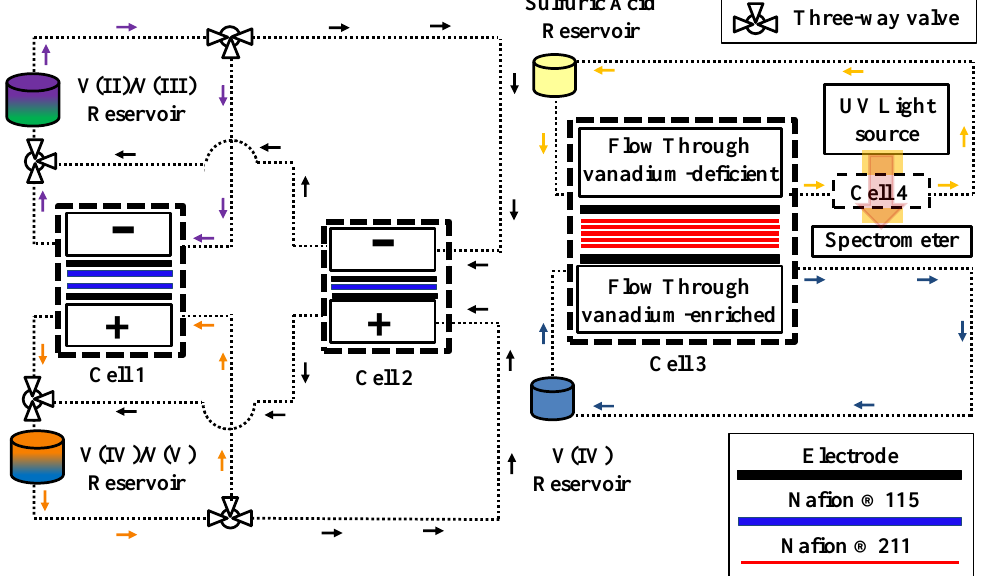
Figure 1. Test configuration used for measuring concentration-gradient-induced crossover; the setup includes several flow cells (Cell 1, 2, and 3), electrolyte reservoirs, and UV/Vis spectroscopy apparatus including UV light source, spectrometer, and UV cell (Cell 4) [16].